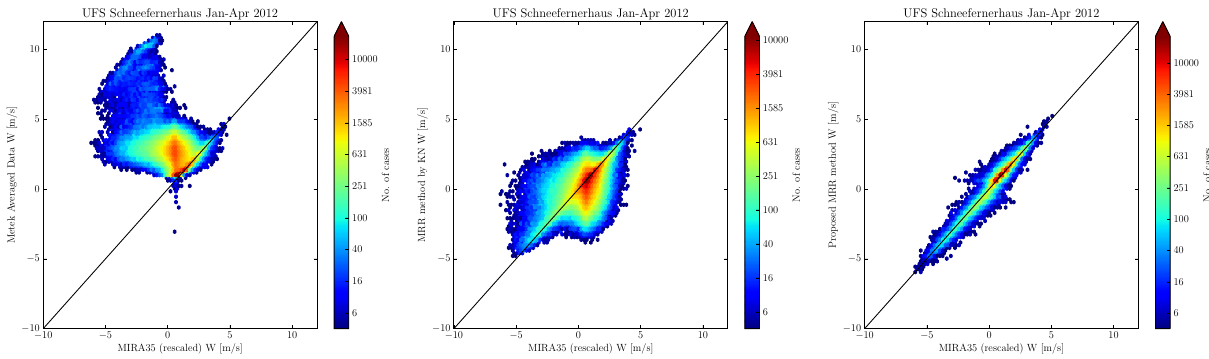
Fig. 9. Scatterplot comparing Doppler velocity ( W ) of MIRA35 with W of Metek’s standard MRR product (left), with W of MRR using the method by KN (centre) and with W of MRR using the new proposed MRR method (right). The black line denotes the 1 : 1 line.